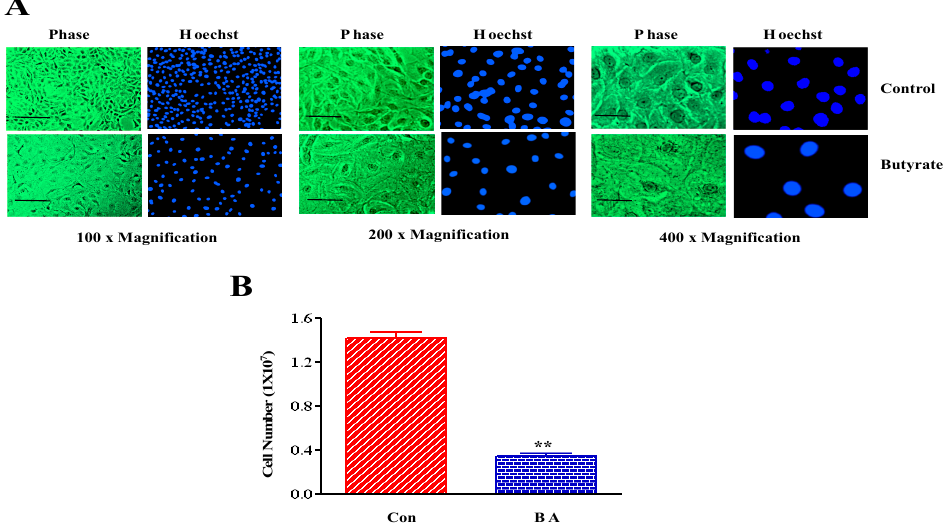
Figure 1. Cellular effects of butyrate on VSMCs. Proliferating VSMCs treated with (BA) or without (Con) 5 mM butyrate for 72 h and processed for assessing butyrate-induced cellular effects. ( A ) Pseudocolored phase contrast images and corresponding nuclear images of VSMCs stained with Hoechst reveal butyrate-induced altered cell morphology and increase in size. The scale bar is 50 µ